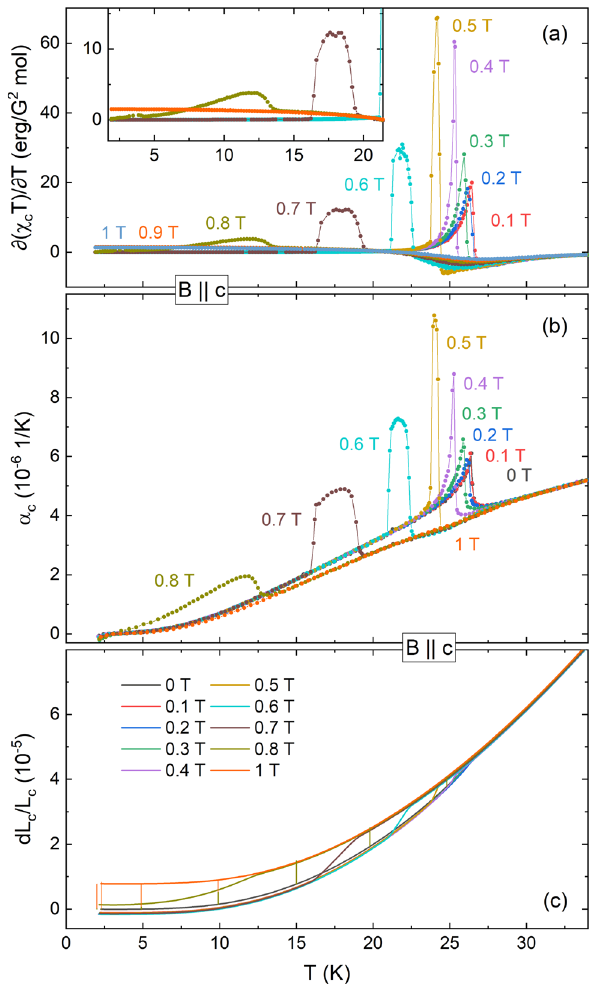
Figure 3. Fisher’s specific heat and thermal expansion up to B = 1 T : ( a ) Fisher’s specific heat calculated from the static magnetic susceptibility, ( b ) thermal expansion coefficient α c , and ( c ) relative length changes, for 0 T ≤ B � c ≤ 1 T. The inset in ( a ) presents a magnification of the low temperature region. Vertical bars in ( c ) mark the relative length changes � L ( B ) from 0 T to 0.8 T (olive green) and 1 T (orange), respectively, obtained from magnetostriction